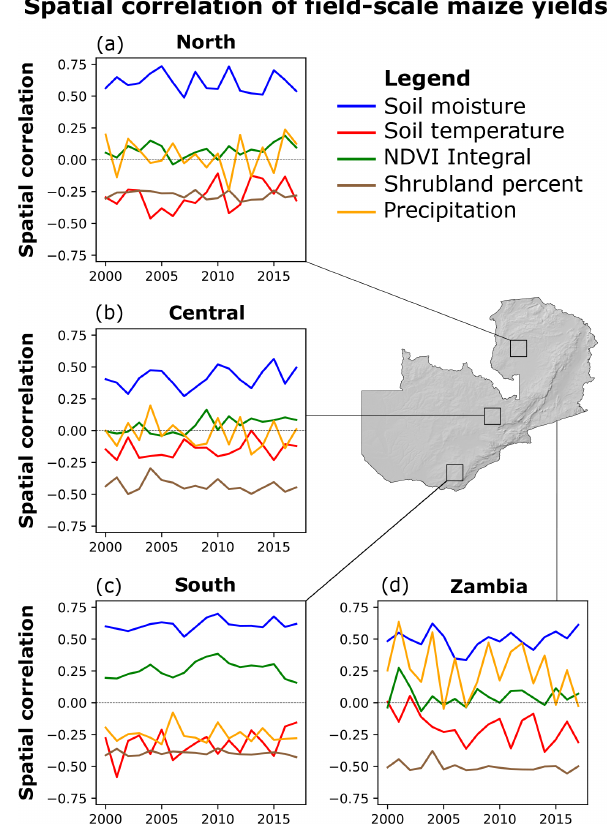
Figure 6. Time series of Pearson spatial correlation of maize yields and the most important predictors. Panels show the spatial corre- lation within 50km by 50km boxes in (a) south, (b) central, and (c) north of Zambia. Panel (d) shows the spatial correlation for the entire